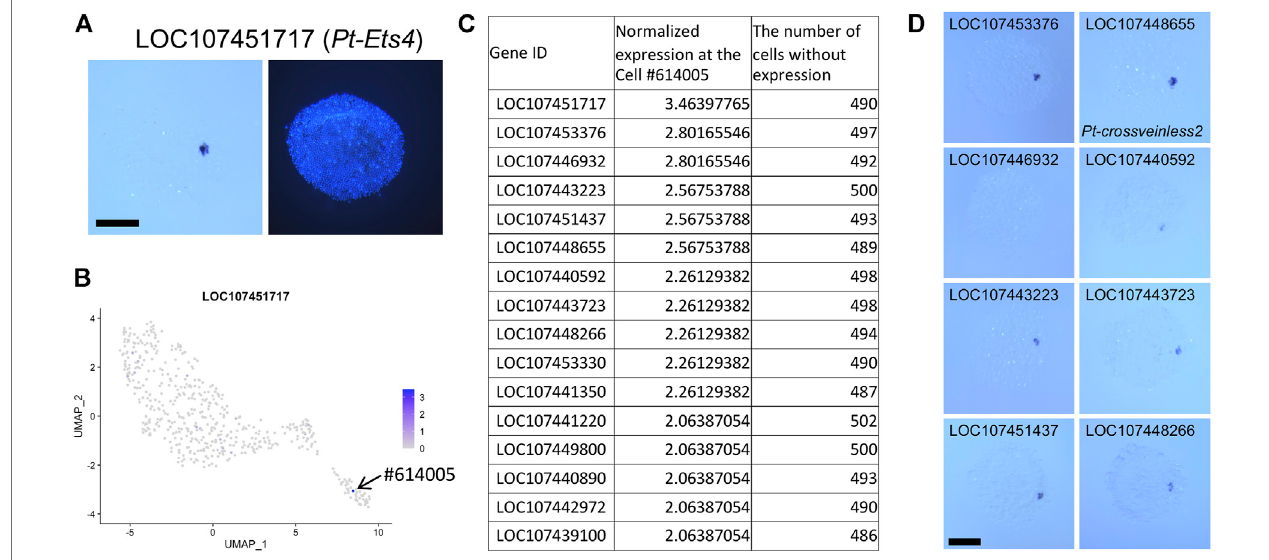
Frontiers in Cell and Developmental Biology |